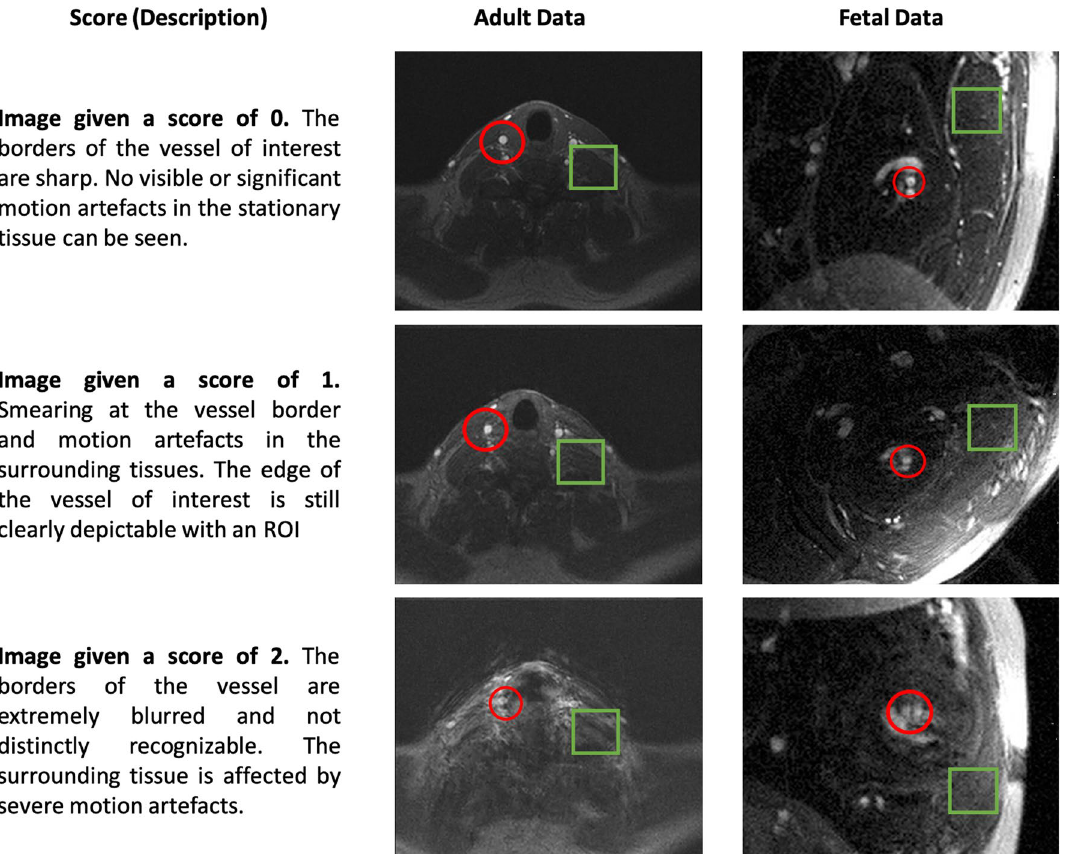
Figure 2. Examples for images prior to the MOG reconstruction. Displayed are examples of images given different scores in fetal scans and in adult volunteers. The red circle indicates the area of interest with the vessel of interest. For the fetus, scans of the AAO are presented, in the adult scans the CA is shown. The green square marks an area of stationary tissue potentially corrupted with motion